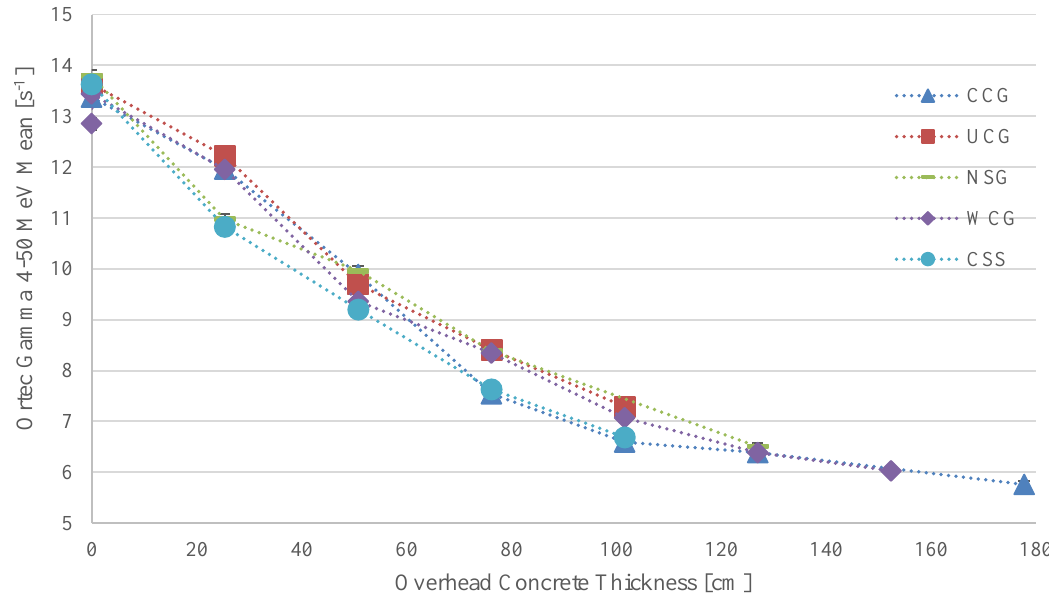
Figure 5. The mean Ortec NaI count rate (between 4 MeV and 50 MeV) at each location in each parking garage plotted as a function of concrete thickness above the detector. The data were collected continuously over 15-20 minutes and had a five second rolling average applied before calculating the mean. 1-σ error bars are shown, but some of them may be obscured by the data markers.